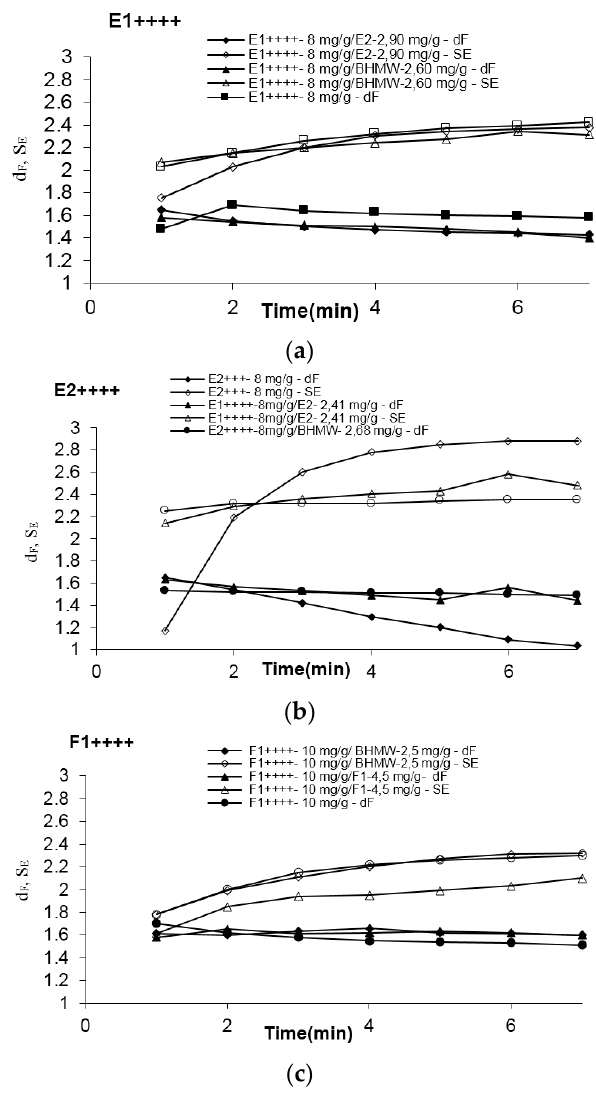
Figure 4. Evolution with time of mass fractal dimension and scattering exponent of the re-flocculated flocs with addition of linear polymer after floc break-up: ( a ) E1++++; ( b ) E2++++; ( c ) F1++++.